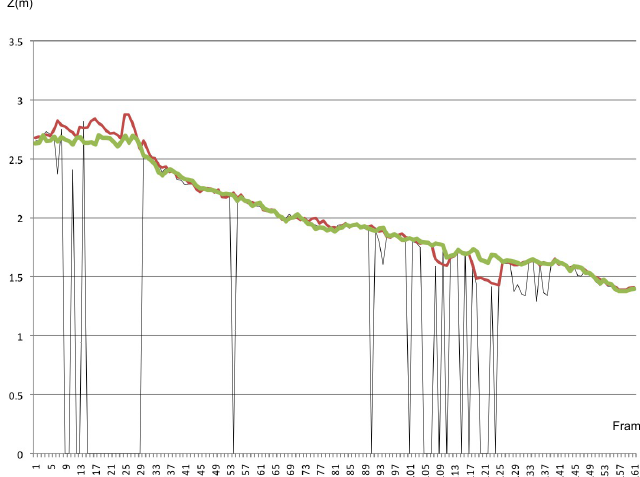
Figure 35. Occlusions zone: this graph is a detail of the graph of the Figure 32, from the frame 124 to frame 284, here we can compare the estimation in the temporary occlusions zone with and without the use of the filter and adding the geometric constraints to the filter. The black curve is the estimation without filter, the red curve is the estimation with filter and the green curve is the estimation using the filter with geometric constraints of the target. The frame 124 was renumbered with the number